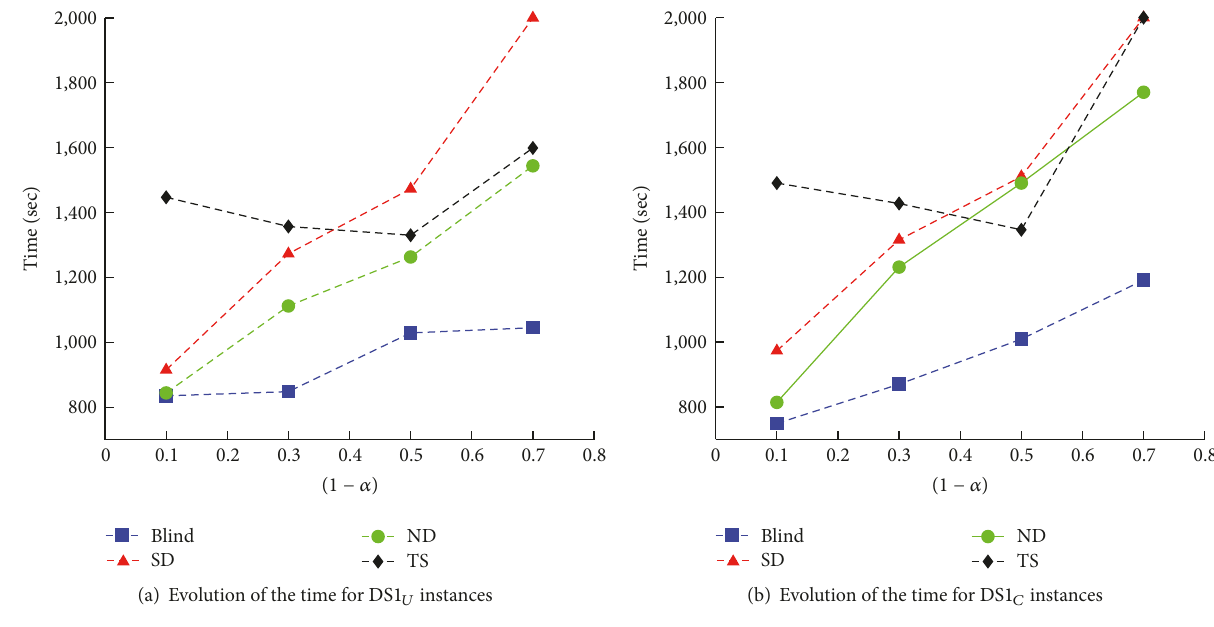
Figure 8: Average times needed by the local search algorithms for each value of (1 − 𝛼) for DS 1